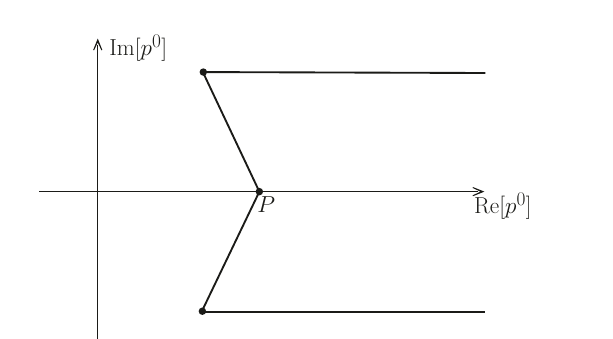
Figure 11 . De(cid:12)nitions of